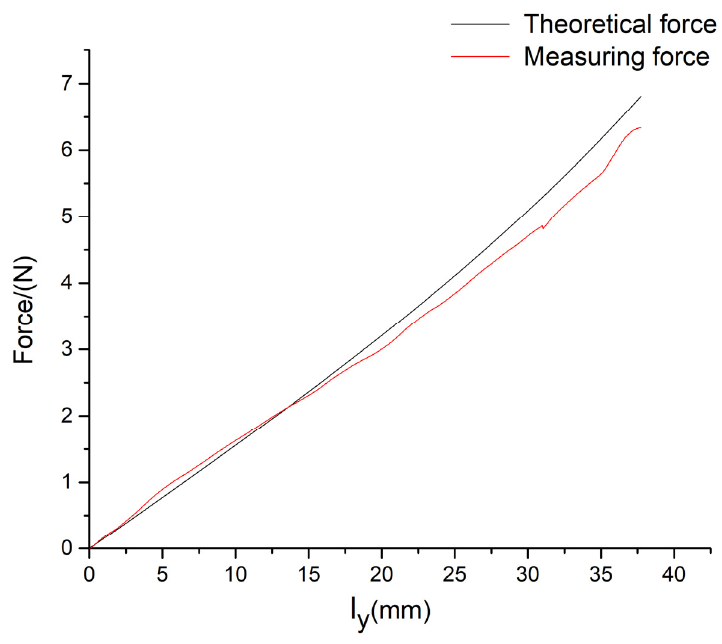
Figure 11. Displacement—force. Figure 11.